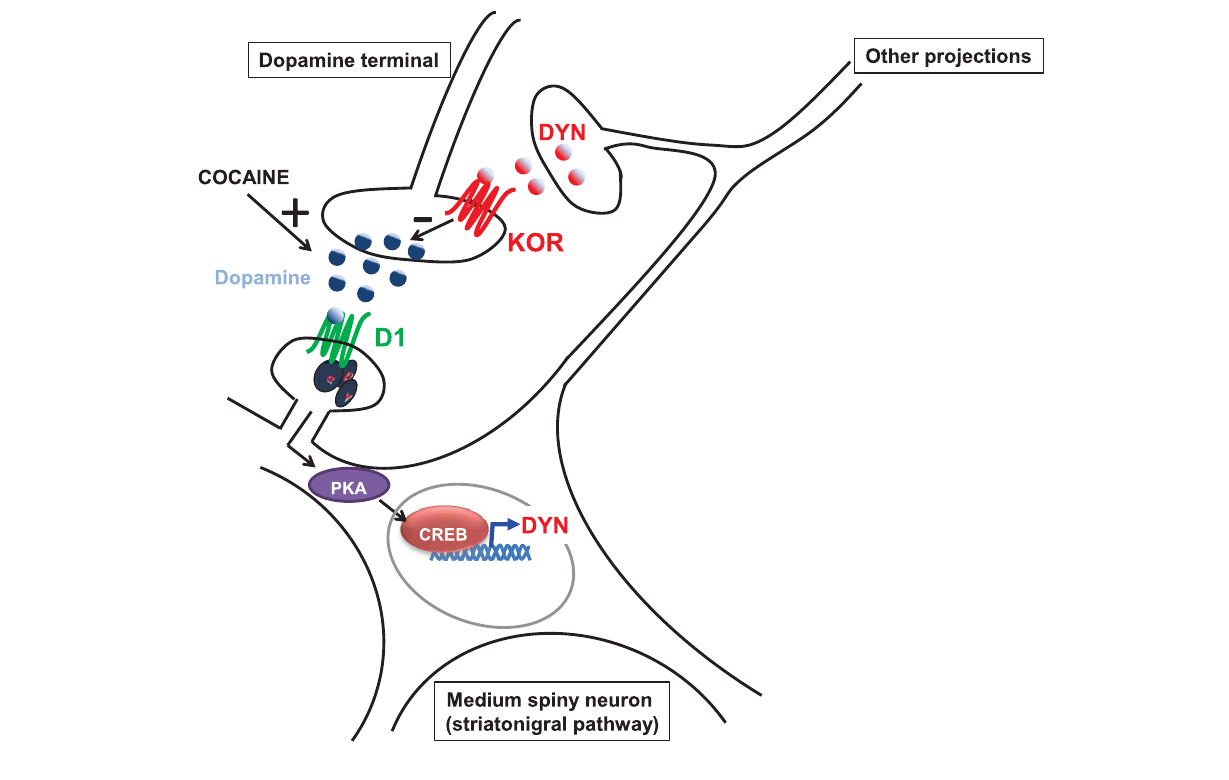
pathway (direct pathway) activates the cAMP/PKA/CREB pathway which leads to dynorphin (DYN) synthesis. Binding of DYN on kappa receptors (KOR) located on dopamine terminals exert an inhibitory effect on dopamine